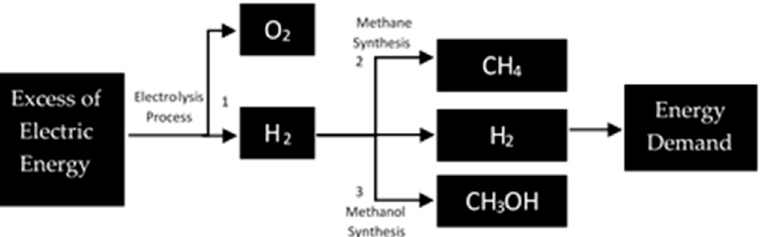
Figure 5. Methods of PtG system: 1. H 2 gas is produced from the electrolysis electric energy process; 2. CH 4 gas is produced by processing H 2 through a methane-synthesis process; 3. H 2 treated with a methanol-synthesis process produces methanol (CH 3 OH); Adapted from [46].